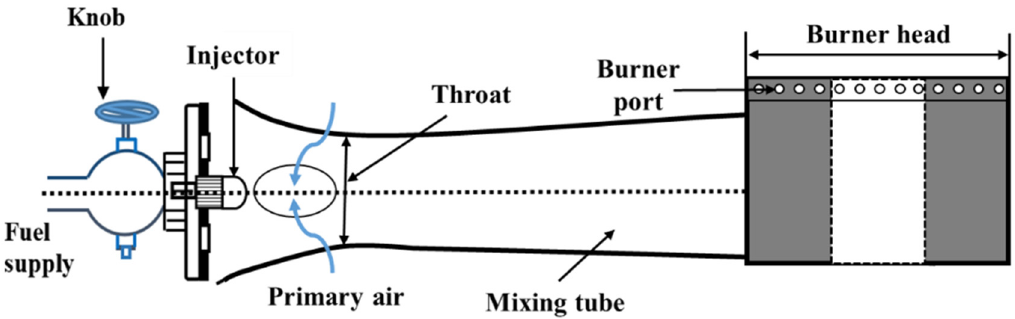
Figure 1. Phenomenon of the natural induction of air in a typical self-aspirated burner. The fuel is supplied through an orifice and is ejected at a high velocity. The surround- ing air is entrained due to the pressure difference created by the high velocity of the jet. The entrained air and fuel then form a mixture and are passed through the mixing tube.